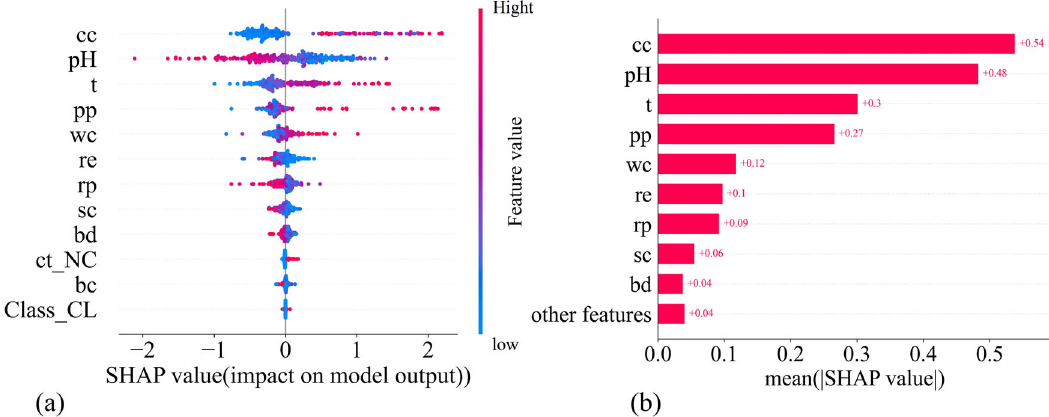
Fig. 6 SHAP global interpretation. a SHAP value for all samples of key features, b Mean SHAP value of